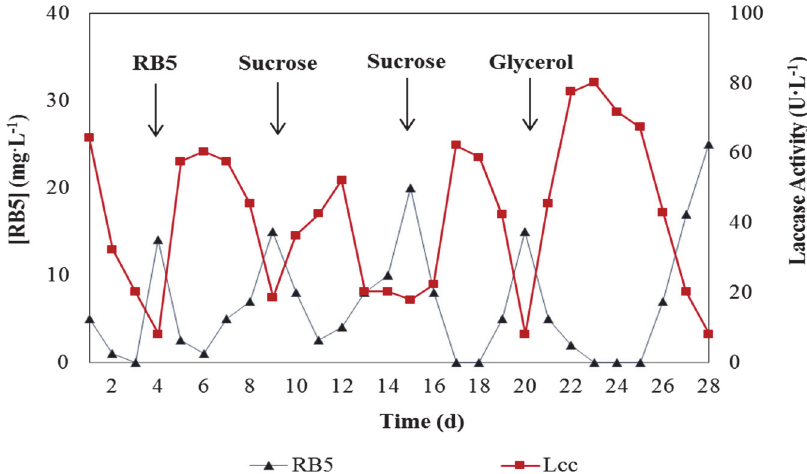
Figure 3. Time course of Reactive Black 5 (RB5, 0.1 g ∙ L − 1 at pH 9.5) concentration and Lcc activity using T. versicolor . The bioreactor operated in batch mode with LCM until total decolourisation and was then continuously fed with RB5 at day 4. Rows indicated when the pulses of different carbon sources at concentration of 5 g ∙ L − 1 were added to the RB5 solution at days 9, 15 and 20.